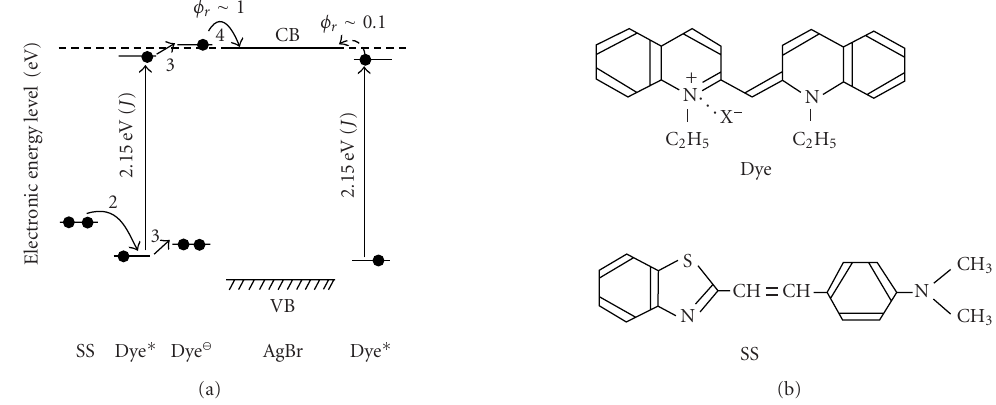
Figure 5: An illustration showing the mechanism of supersensitization for an ine ffi ciently sensitizing dye (Dye) by a supersensitizer (SS) on silver bromide, where Φ r is the quantum yield of the electron transfer in dye sensitization, and Dye ∗ and Dye (cid:3) are the dye in the excited state and the dye in one-electron-surplus state, respectively.